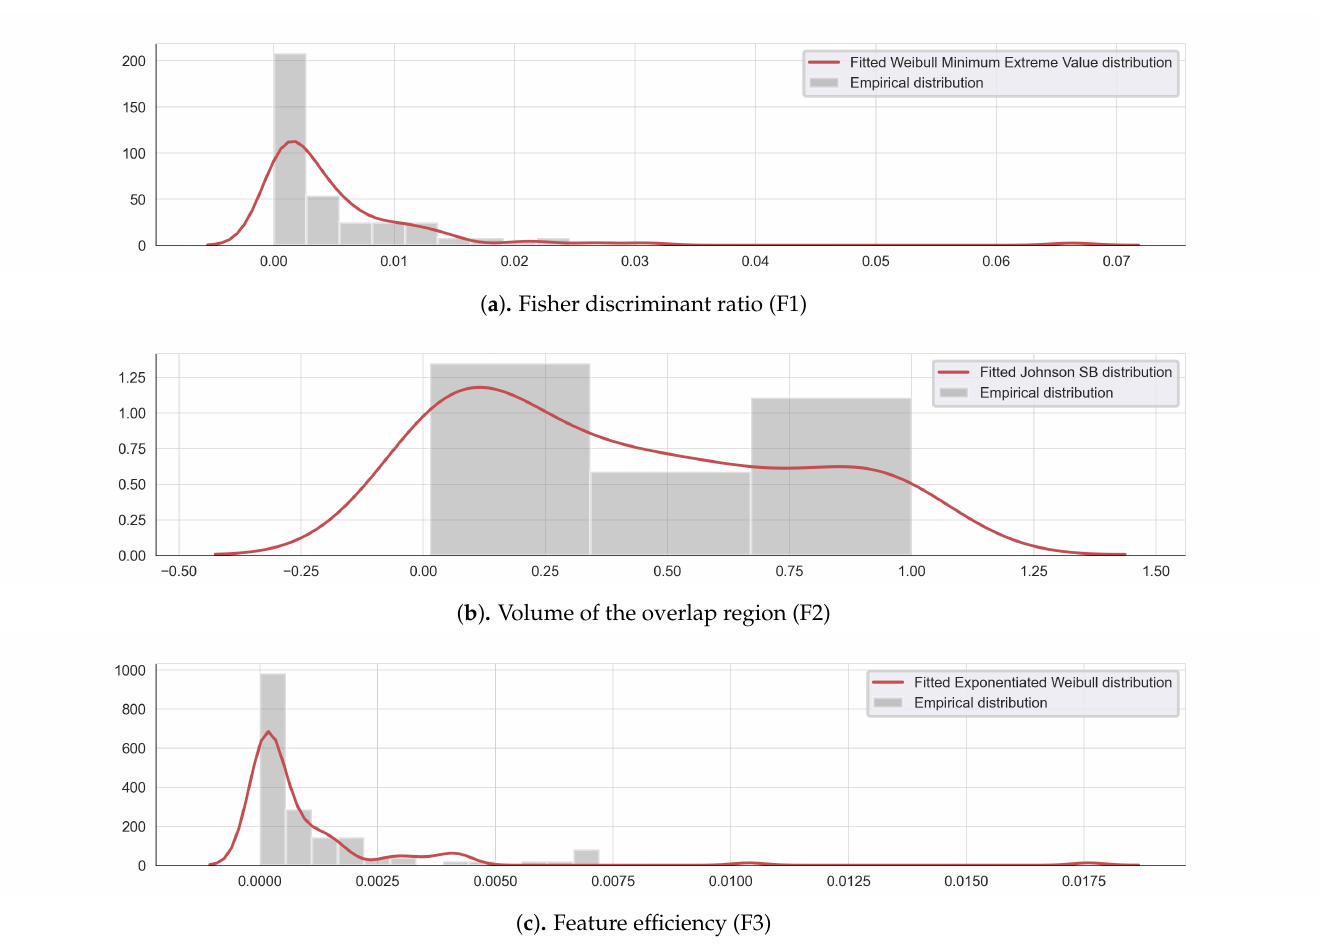
Figure 2. Empirical and fitted distribution for the complexity measures: ( a ) Fisher discriminant ratio F1, ( b ) the volume of the overlap interval F2, and ( c ) the individual feature efficiency F3. Table 1. Thresholds for the complexity